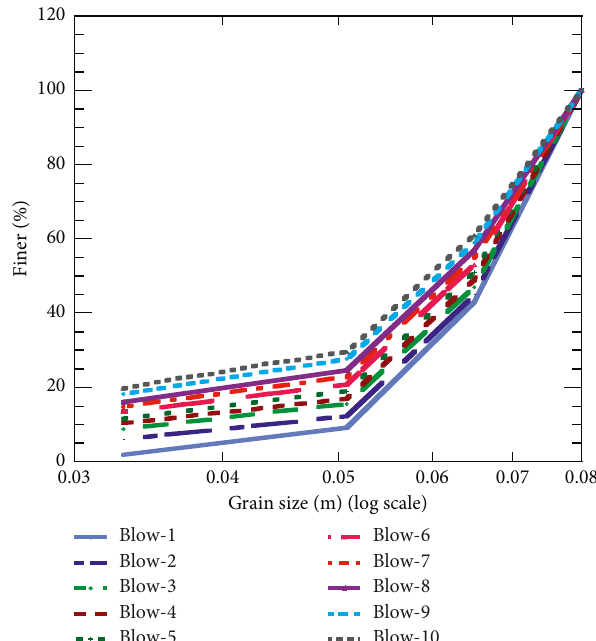
Figure 9: Particle gradation near the impact point under 10